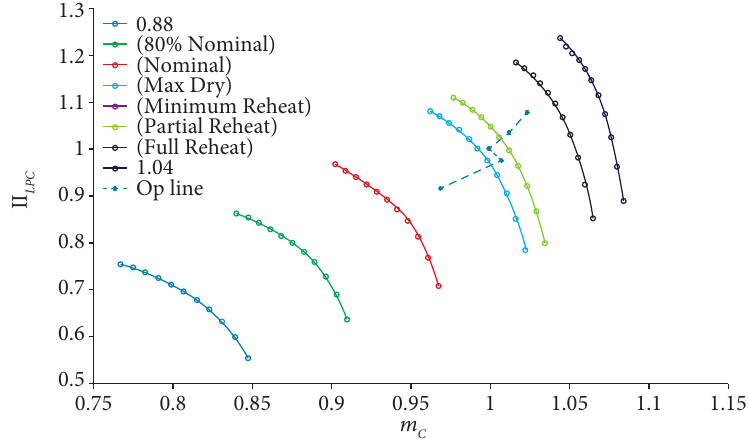
Figure 7. HPC map with experimentally obtained operating line before application scaling function on map. The figure shows that the experimental mass flow rate and pressure ratio do not lie on the respective RPM lines of the characteristics